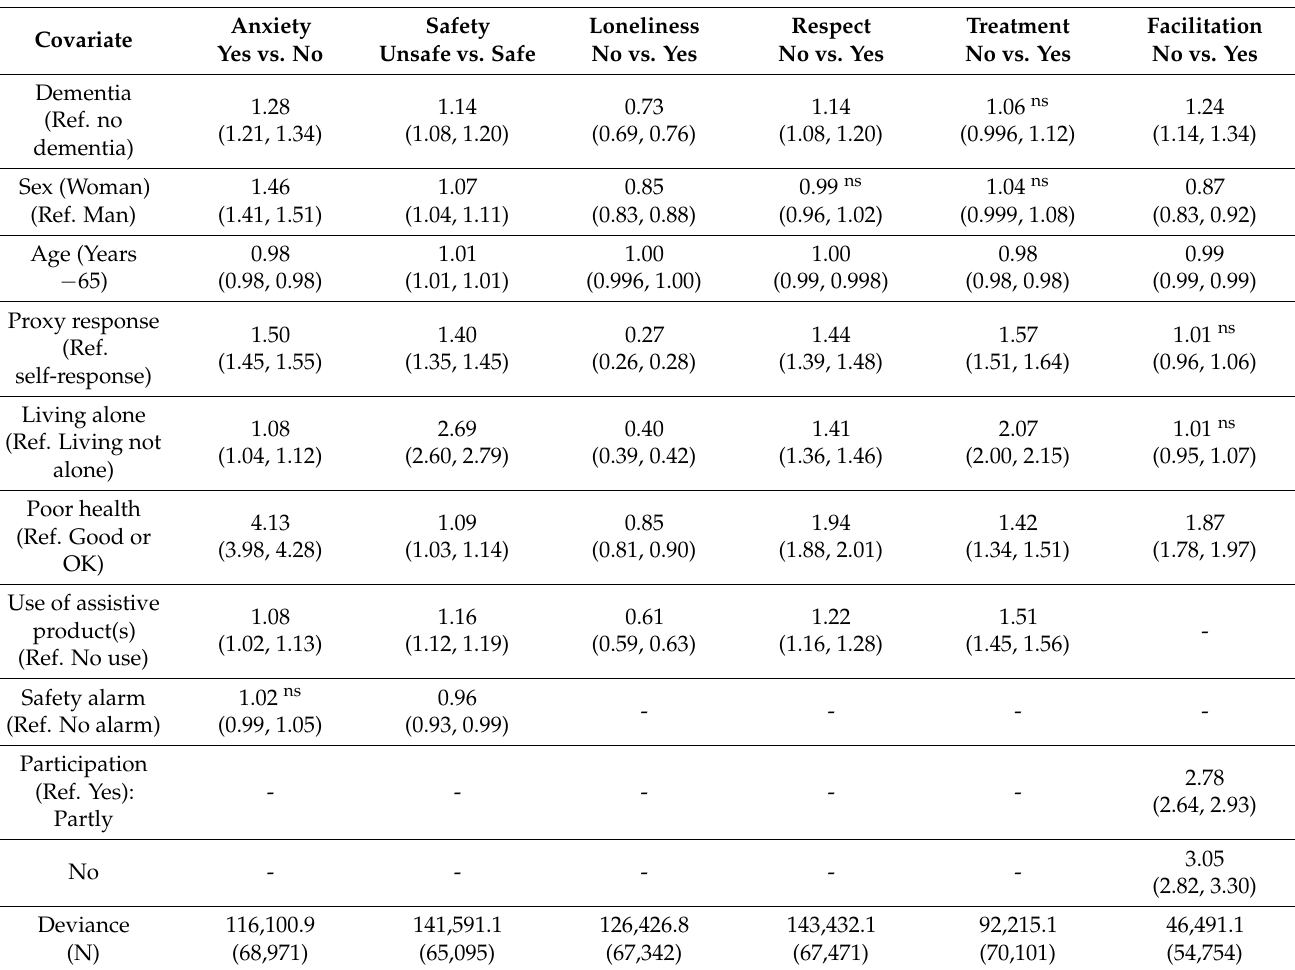
Table 4. Estimated cumulative odds ratios from cumulative logit models (95% confidence interval in